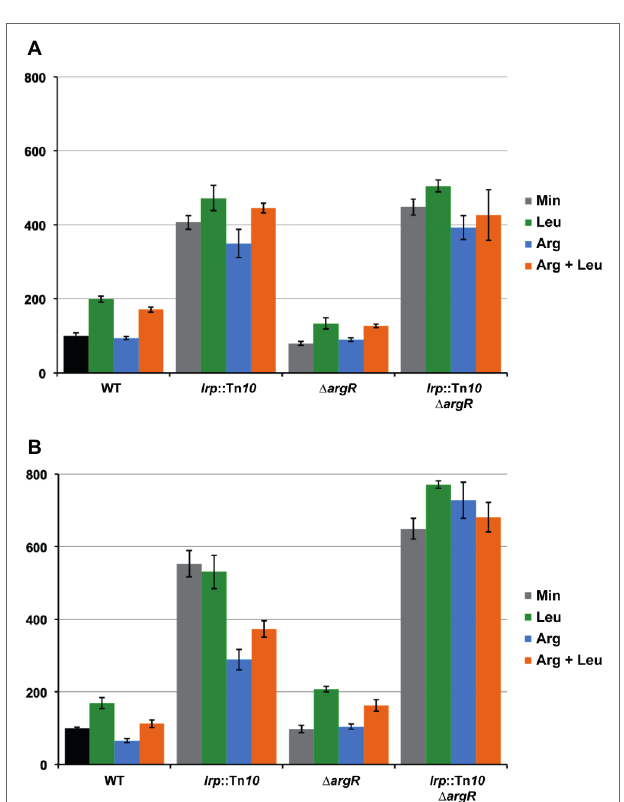
FIGURE 8 | Histogram presentation of β -galactosidase specific activities measured in cell-free extracts of E. coli strain FW102 (WT) and its isogenic lrp ( lrp ::Tn 10 ), argR (∆ argR ) and double lrp argR ( lrp ::Tn 10 ∆ argR ) mutants bearing the wild type lrp promoter/operator- lacZ (A) or mutant lrp ∆25 promoter/ operator- lac Z fusion (B) on a single-copy F’ episome. Cells were grown in minimal medium, when indicated supplemented with l -arginine, l -leucine, or both. Values are the means ± standard deviation of at least three biological replicates. 100% corresponds to the activity measured for each fusion construct introduced in the WT strain and grown on minimal medium (black colored bar).